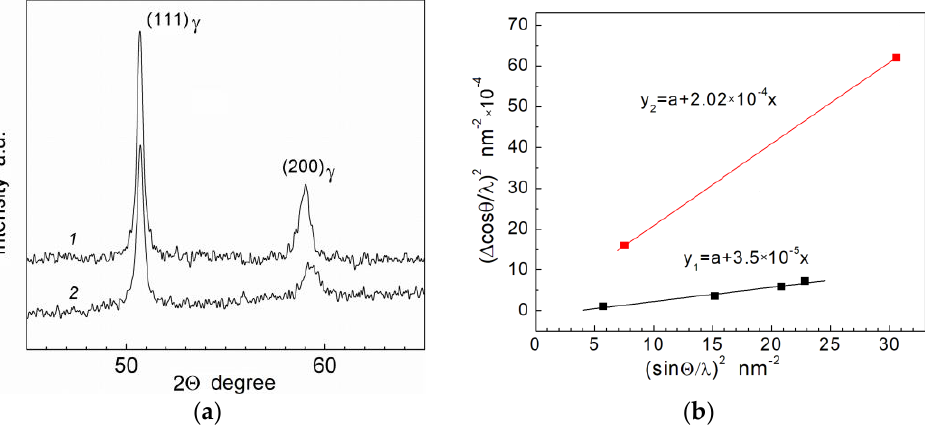
Figure 11. Fragments of the diffraction patterns of Cr-Mn-N steel before (1) and after (2) the impact bending test at T = − 196 ºС (the fracture surface was analyzed in the latter case) ( a ); linear depend- ences y 1 for the planes (111), (220), (311), (222) and y 2 for the planes (200) – (400), in which a = 0 within the range of a measurement error ( b ).